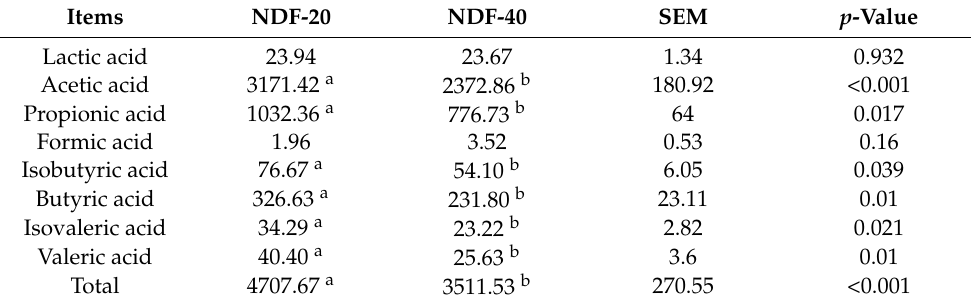
Table 9. Effect of different fiber levels on SCFAs in the feces of Diqing Tibetan pigs,